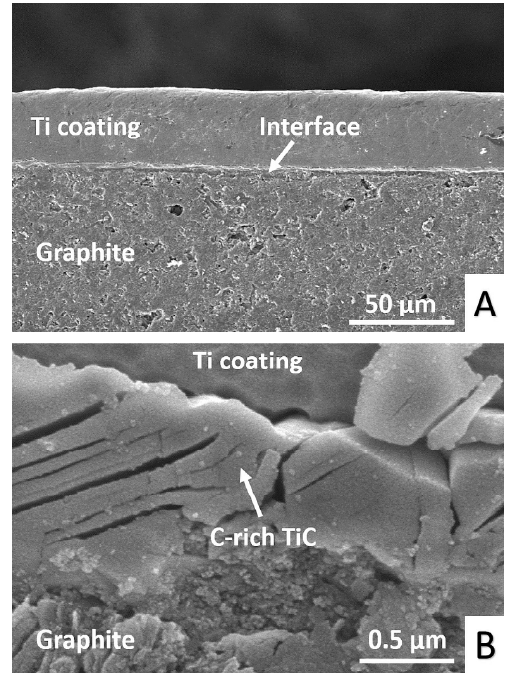
Fig. 2 . SEM micrographs of the titanium coating on graphite etched with 100 ml H H O for 10 seconds to expose carbides: (A) Fully 2 2 dense and crack-free Ti deposit, and (B) the coat- ing-graphite interface composed of C-rich TiC.